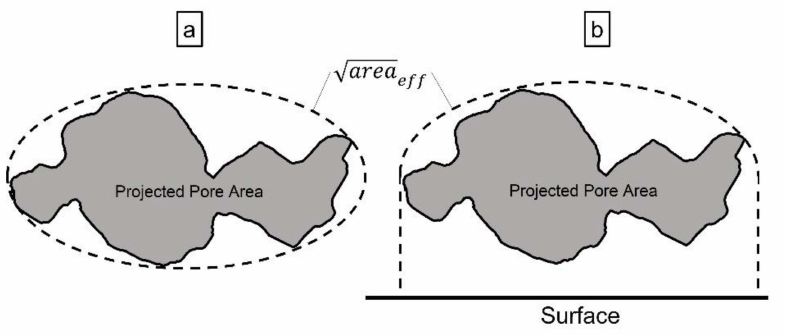
√ area eff ) which is estimated by considering a smooth contour Figure 7. Definition of effective area ( circumscribing the original pore shape in case of ( a ) an internal pore and ( b ) a near-surface